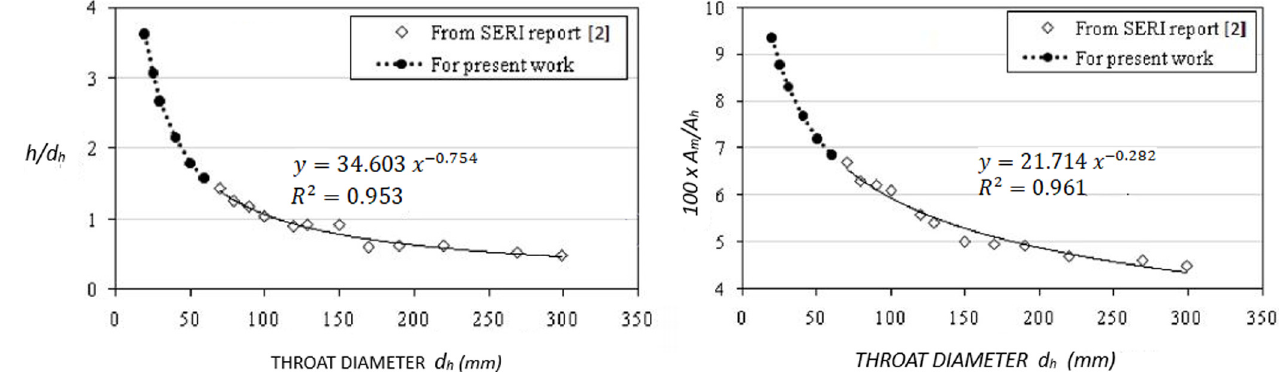
Fig. 3. Plots for design small gasi fi ers (adapted from [23]).